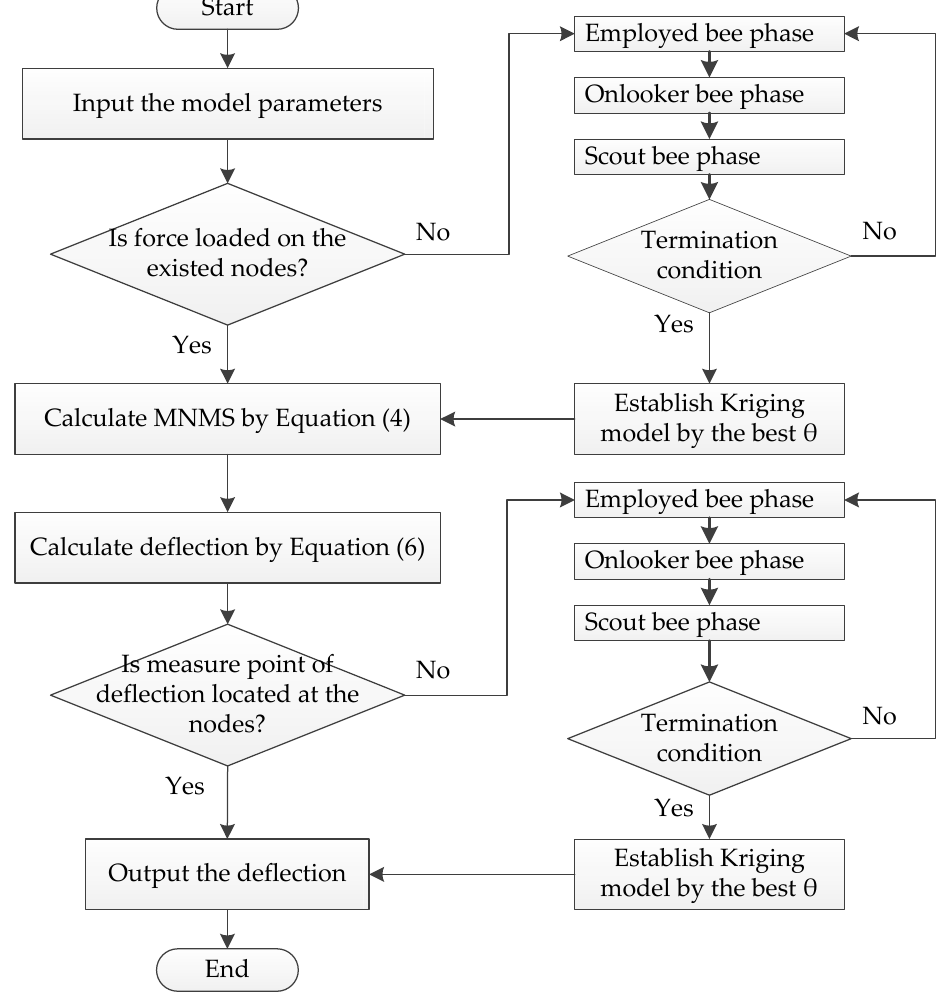
Figure 1. Flowchart of the proposed approach to calculate bridge deflection.